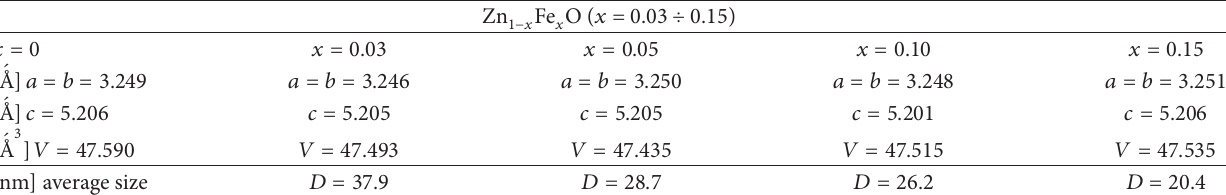
Table 2: Lattice parameters calculated from the XRD data of Zn 1−𝑥 Fe 𝑥 O ( 𝑥 = 0.03÷0.15 ) and mean crystalline size (Debye-Scherrer formula [18]). Zn 1−𝑥 Fe 𝑥 O ( 𝑥 = 0.03 ÷ 0.15 )